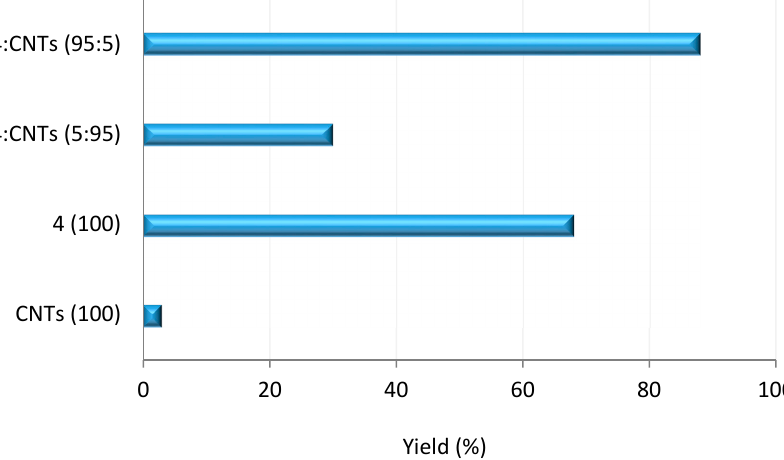
Figure 6. Influence of different additives on the yield of acetophenone. Reaction conditions: 5 mmol of substrate, 0.33 mmol of catalyst 3 or 4 , 5 mmol of t -BuOOH, 0.125 mmol of additive, 1 h, 80 °C, 5 W.